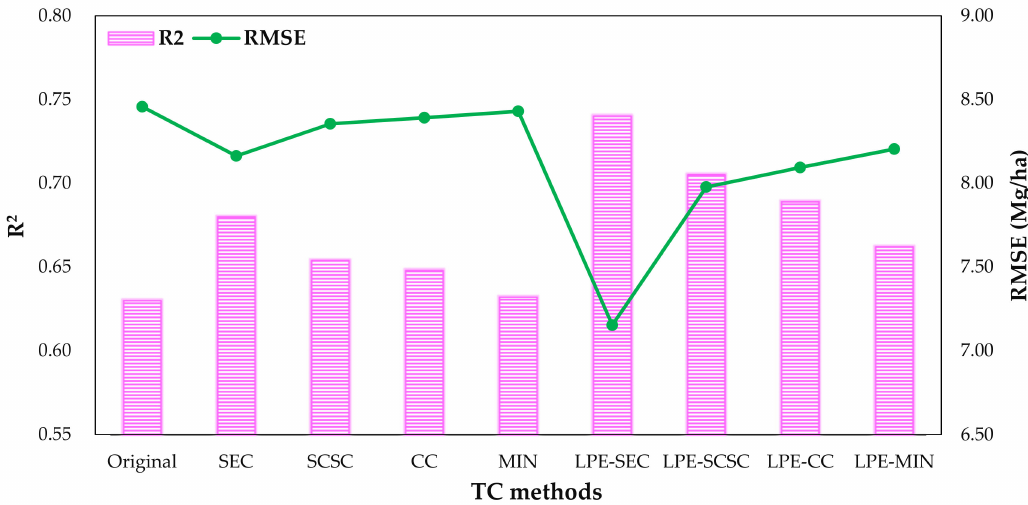
Figure 6. The R 2 , and root mean square error (RMSE) of the forest carbon density predicted by SVR using the original image, the images corrected by traditional TC models and the images corrected by LPE-TC